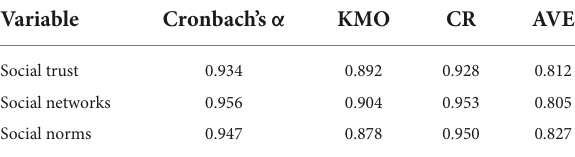
TABLE 3 Reliability and validity test results.